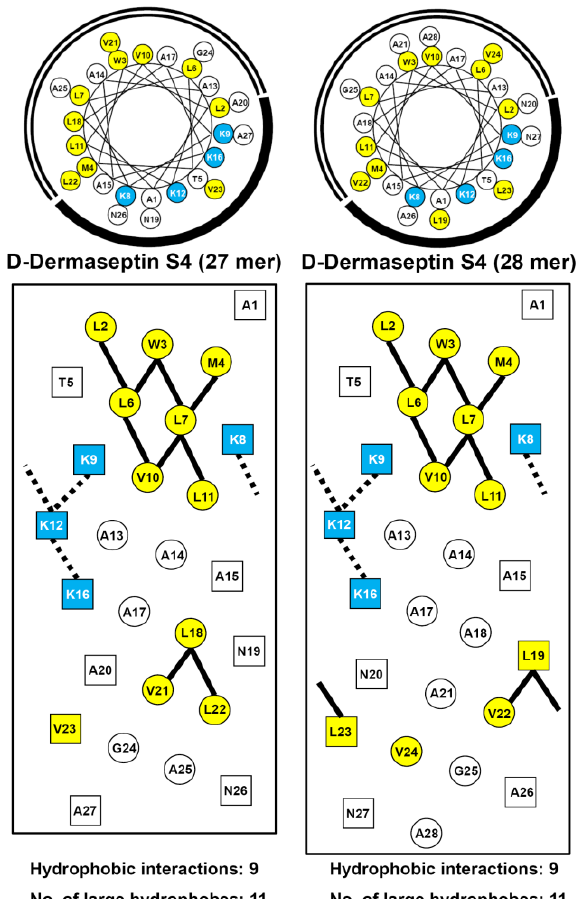
Figure 3. Helical wheel (upper panel) and helical net (lower panel) representation of D -dermaseptin S4 (27 mer) and D -dermaseptin S4 (28 mer). The one-letter code is used for amino acid residues. D denotes that all residues in the peptides are in the D conformation. Positively charged residues (Lys) are colored blue, large hydrophobic residues (Val, Leu, Met and Trp) are colored yellow. In the helical wheel, the non-polar face is indicated as an open arc and the polar face is shown as a solid arc. In the helical net, the residues on the polar face are boxed and the residues on the non-polar face are circled. The i → i +3 and i → i +4 potential hydrophobic interactions along the helix are shown as black bars. The i → i +3 and i → i +4 potential electrostatic repulsions between positively charged residues along the helix are shown as dotted